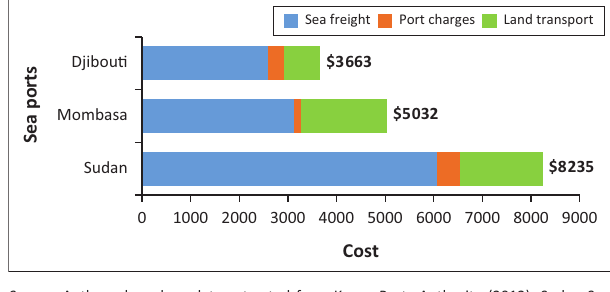
FIGURE 5: Cost of importing a 20-foot equivalent units container from Shanghai to Modjo.